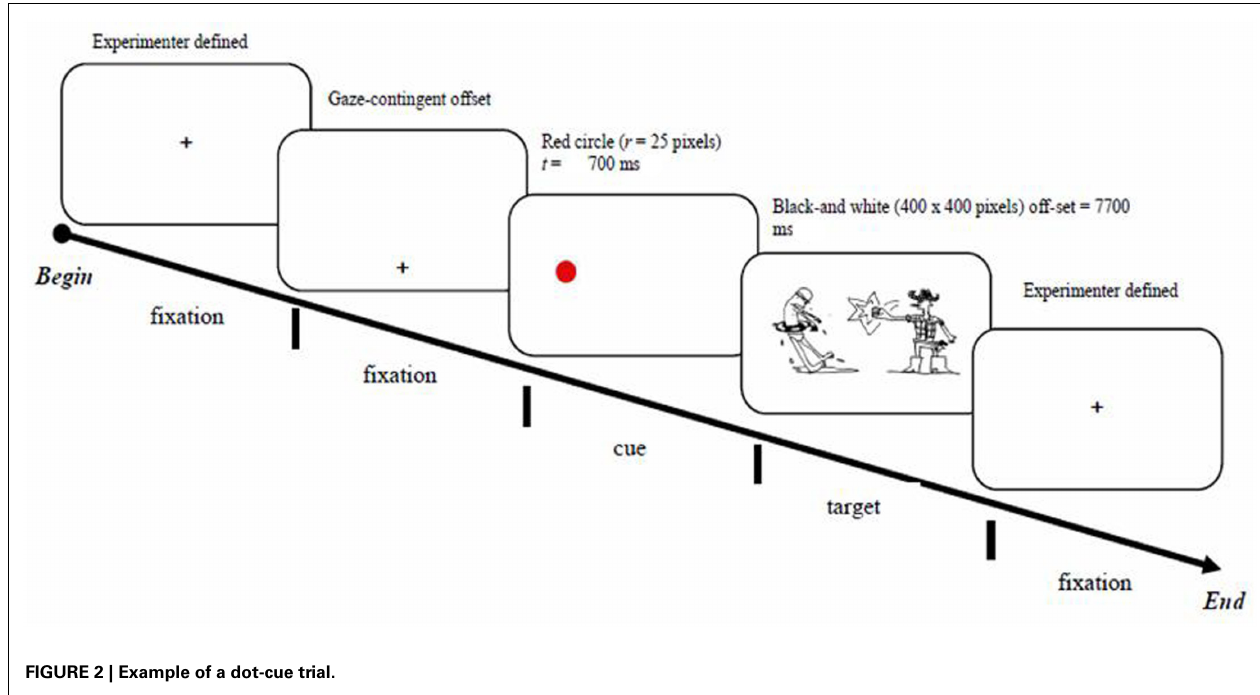
FIGURE 2 | Example of a dot-cue trial.